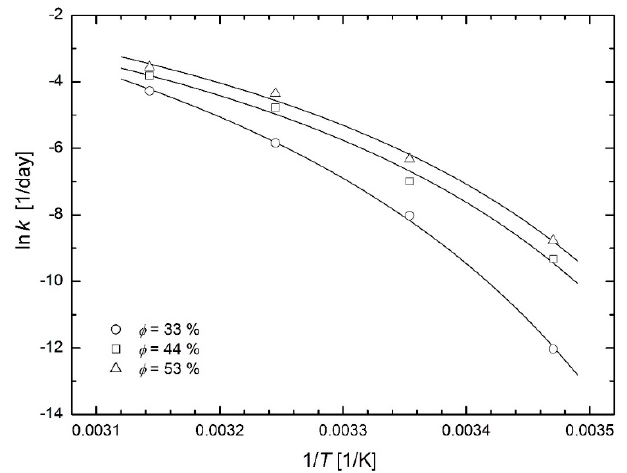
Figure 10. Modified Arrhenius plots for reaction rate constants of browning in freeze-dried onion at various relative humidity [24] (common value of temperature T 0 = − 18 ◦ C for all values of relative humidity).